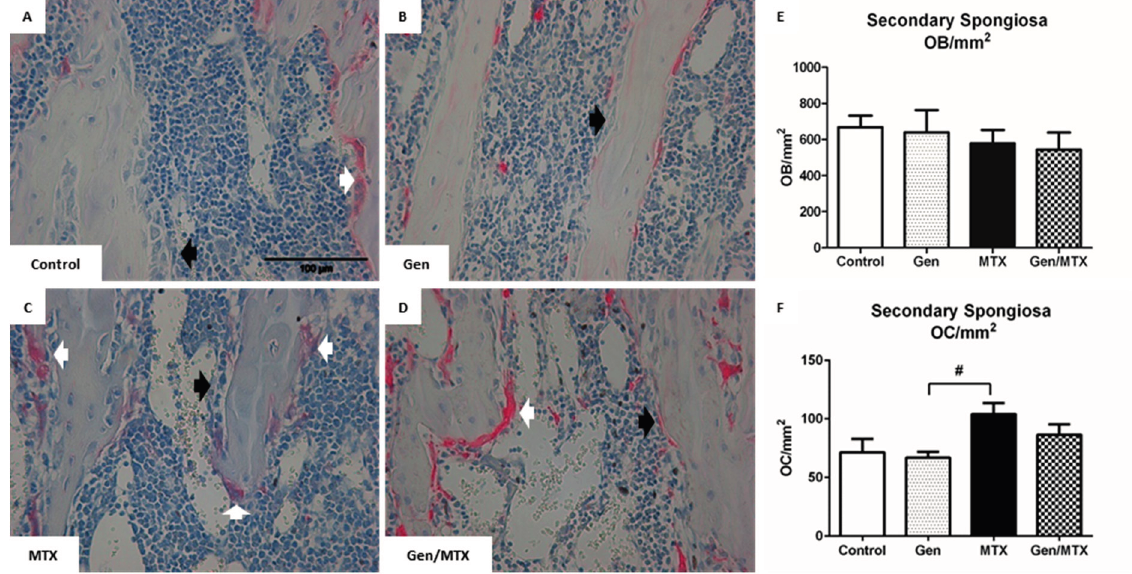
Figure 3. MTX treatment increased the density of bone-resorbing osteoclasts and genistein had no significant effect on densities of the remodeling cells. ( A – D ) Representative images (40×) of H&E-stained tibial metaphysis sections from a control, genistein (Gen)-, MTX-, or genistein + MTX (Gen/MTX)-treated rat, respectively, which have been counterstained with TRAP for osteoclast identification (white arrows: osteoclasts or OC; black arrows: osteoblasts or OB); ( E ) Quantification of osteoblast density (OB/mm 2 ) within the secondary spongiosa region of the metaphysis; ( F ) Quantification of osteoclast density (OC/mm 2 ) identified as multinucleated ( ≥ 3 nuclei) TRAP + cells (white arrows). n = 6, # p < 0.05 between MTX and Gen